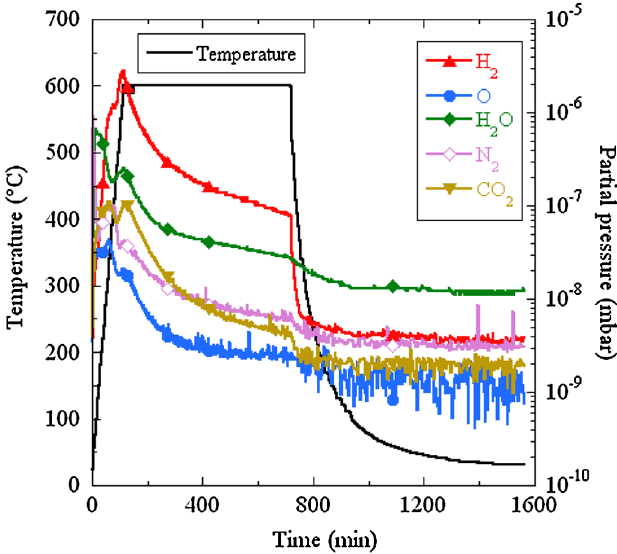
FIG. 10. (Color) Partial pressure of the residual gases and tem- perature profile during the 600 (cid:1) C = 10 h heat